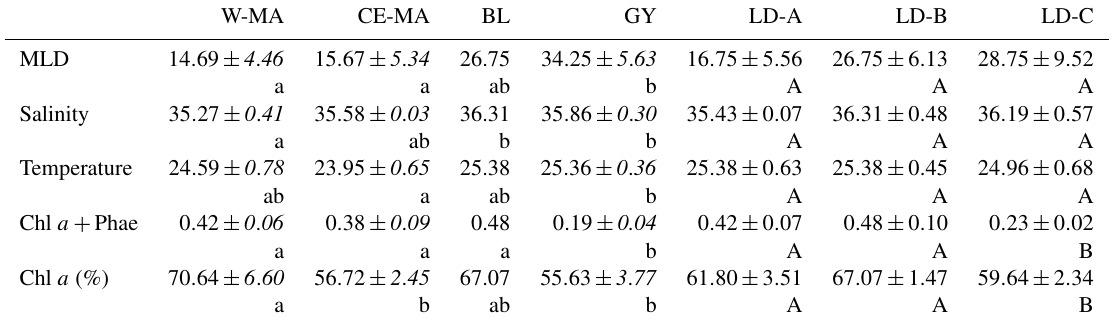
Table 1. Mean values ( ± standard deviation, in italics) of salinity, temperature ( ◦ C), total chlorophyll a and phaeophytin (Chl a and Phae in µgL − 1 ), %Chl a , and mixed layer depth (MLD) (m) found at the stations for the four clusters defined in the PCA on environmental variables (see Fig. 1) and for the three long-duration stations. W-MA: western Melanesian archipelago; CE-MA: central and eastern Melane- sian archipelago; BL: station B (blooming conditions); GY: subtropical gyre. Letters below the mean values indicate homogeneous groups between zones (small letters) or LD stations (capital letters) according to post hoc Scheffé tests.